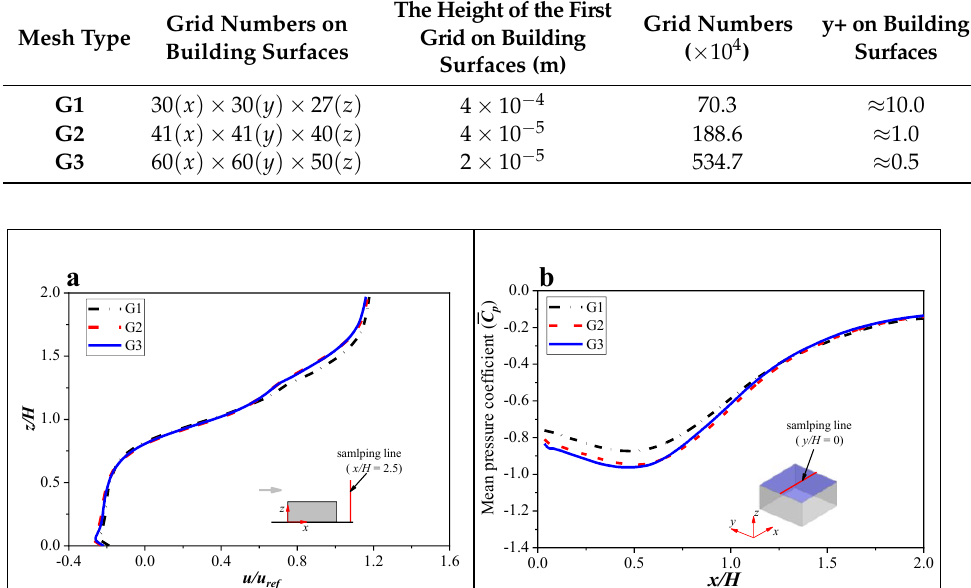
Figure 5. Insensitivity analyses for different grids (( a ) mean velocity; ( b ) mean pressure coefficient).